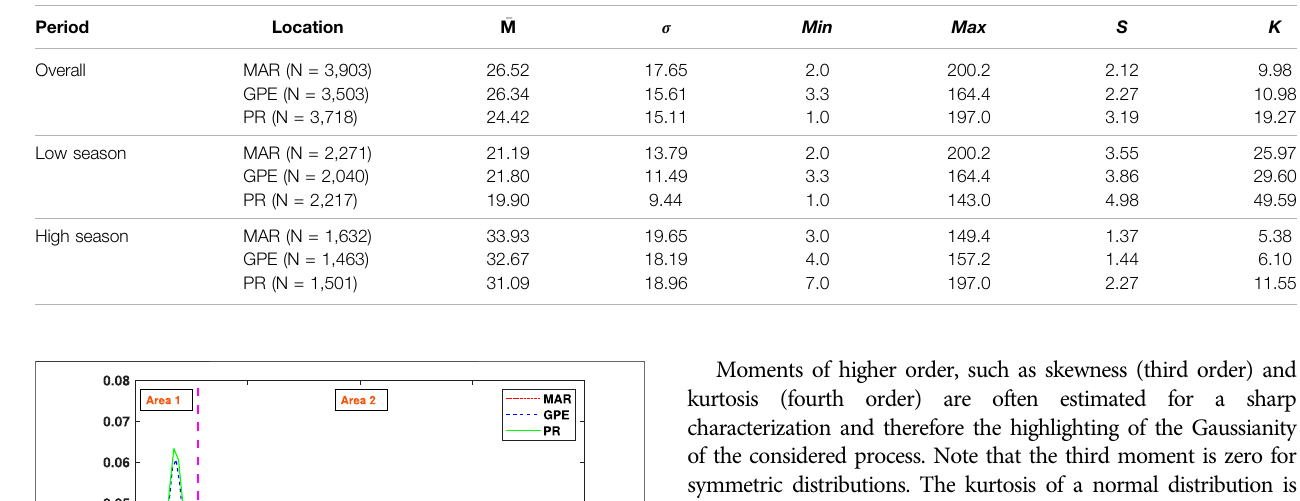
TABLE 1 | Statistical parameters (Mean ( (cid:2) M ) , Standard deviation ( σ ), Minimum ( Min ), Maximum ( Max ), Skewness ( S ) and Kurtosis ( K ) of PM 10 data at Martinique (MAR), Guadeloupe (GPE) and Puerto-Rico (PR) over 11 years, for low (October to April) and high (May – September) dust seasons. (cid:2) M , σ , Min and Max are in μ g / m 3 and N represents the data point number.